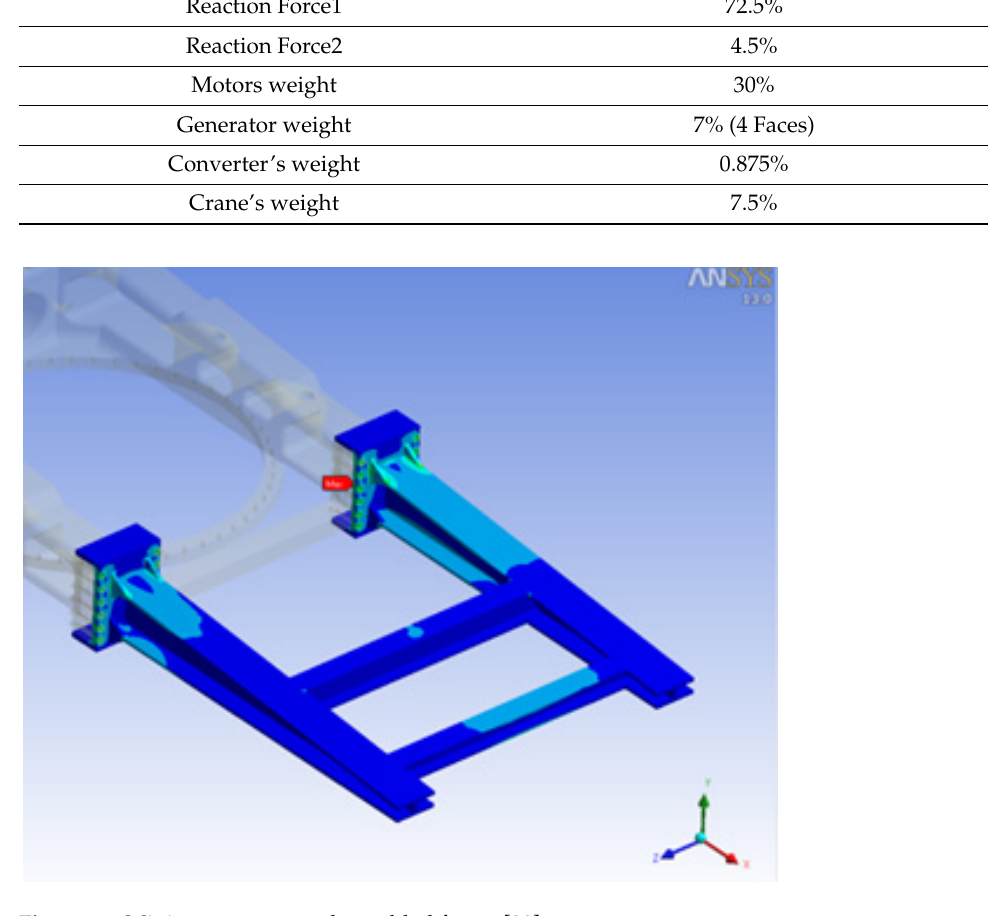
Table 2. Boundary conditions of the minimum stress analysis’ [30]. (Forces were measured as percentage of the overall weight of the nacelle).